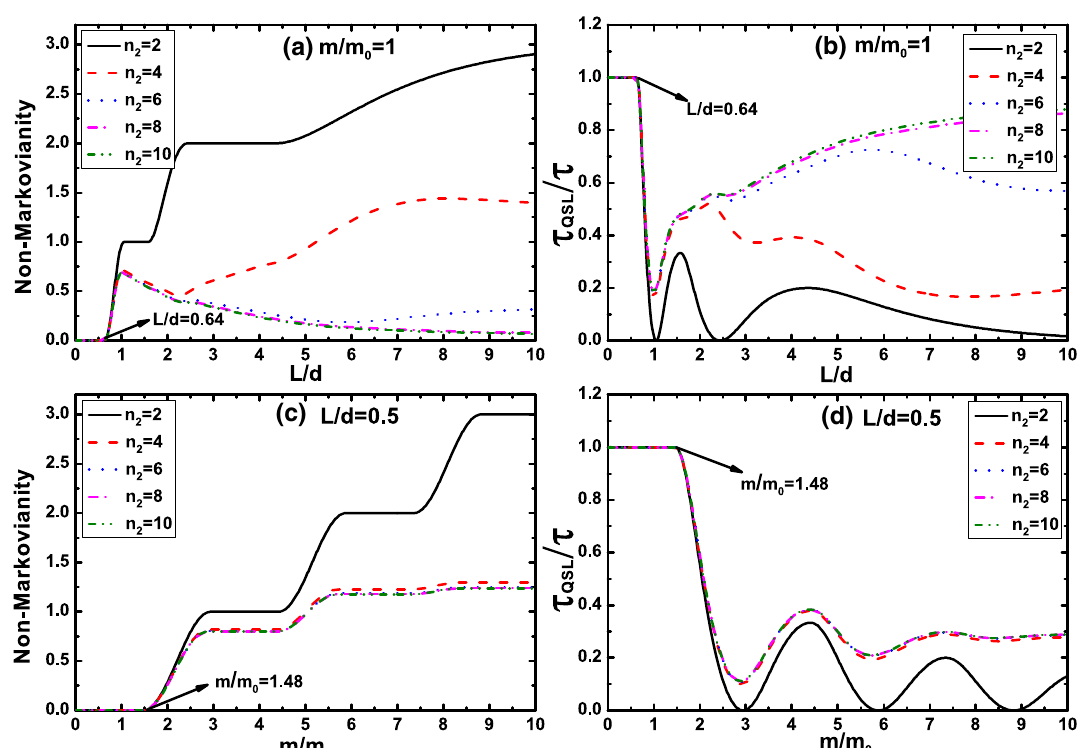
Fig. 4 For the two-side model, the actual evolution time τ = 0 . 4 s, d = 250 µ m and m 0 = 10 − 13 kg. a , c Non-Markovianity N (ϕ) of the dynamics process of the system particle m 0 as a function of L / d and